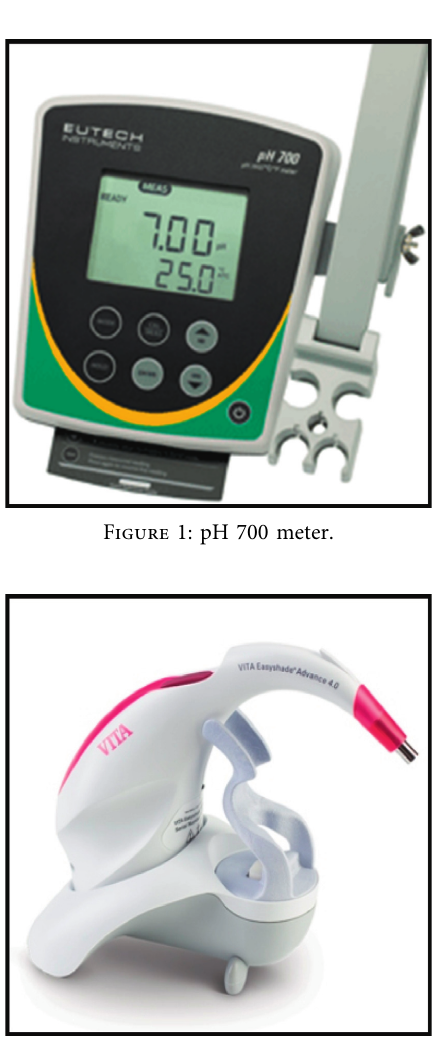
Figure 2: The VITA Easyshade Advance 4.0 spectrophotometer.